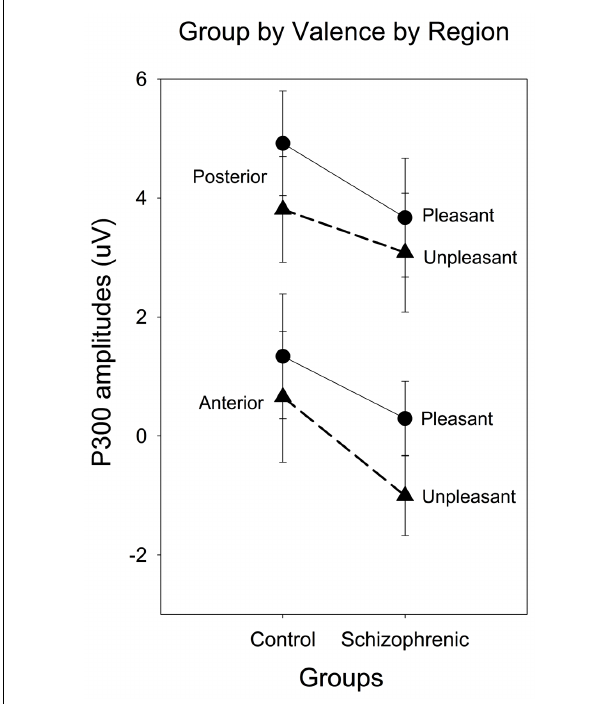
FIGURE 2 | Event-Related Potential (ERP) waveforms for anterior and posterior regions and for left and right hemisphere comparing schizophrenia patients (gray lines) and controls (black lines), contrasting pleasant (solid thin lines) and unpleasant (bold thick